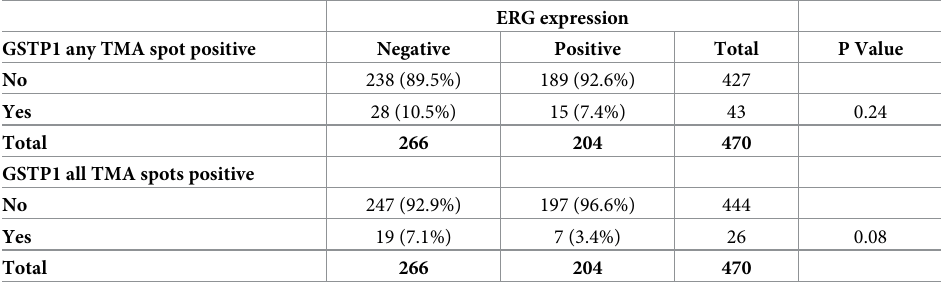
Table 5. GSTP1 protein staining by ERG status